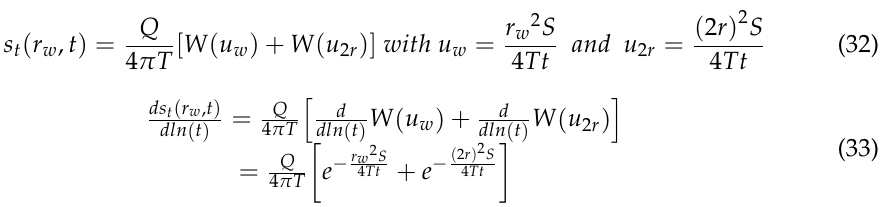
Table 1. Summary of the relevant points of the different approaches.